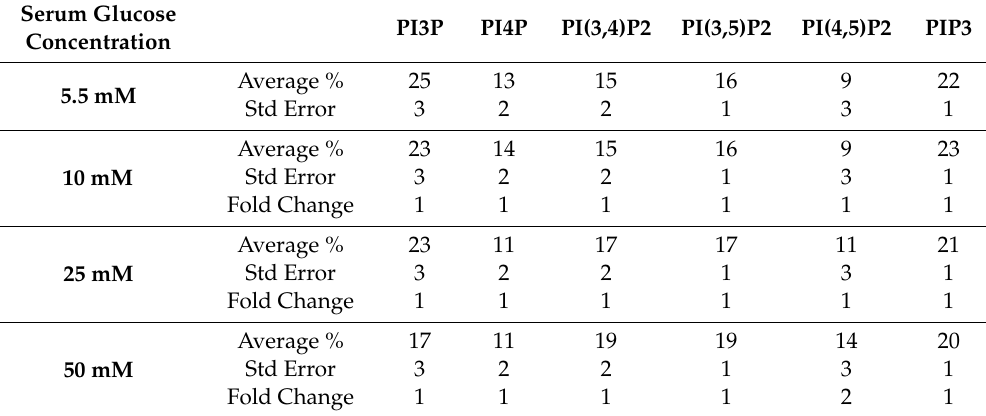
Figure 10. E ff ect of glucose concentration on TNBC breast cancer total PI phosphorylation. The % of total PI lipid PI3P, PI4P, PI(3,4)P2, PI(4,5)P2, PI(3,5)P2, and PIP3 from MDA-MB-468 cells incubated in 5.5 mM, 10 mM, 25 mM, and 50 mM serum glucose concentrations, measured by spot blot analysis ( n = 3). Table 6. Statistical analysis of whole cell lipidome in MDA-MB-468 Cell Line. Serum